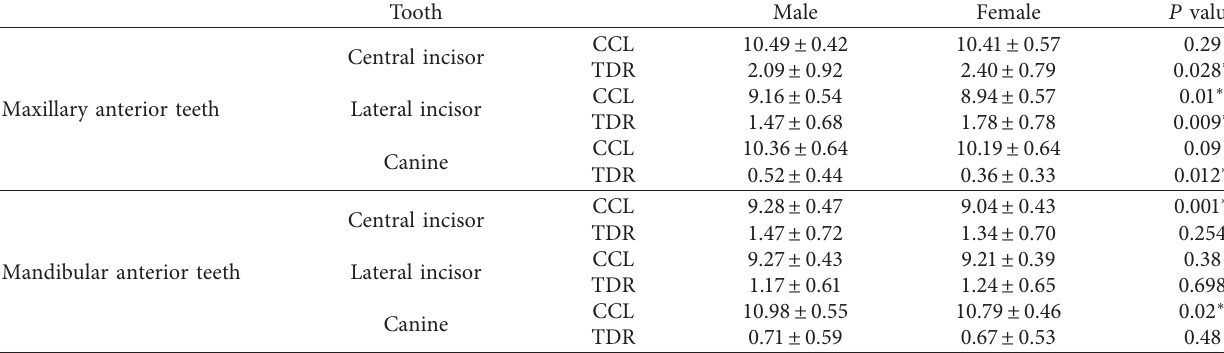
Table 2: Mean ± standard deviation (mm) of clinical crown length (CCL), vertical tooth display at rest (TDR), and the difference between male and female